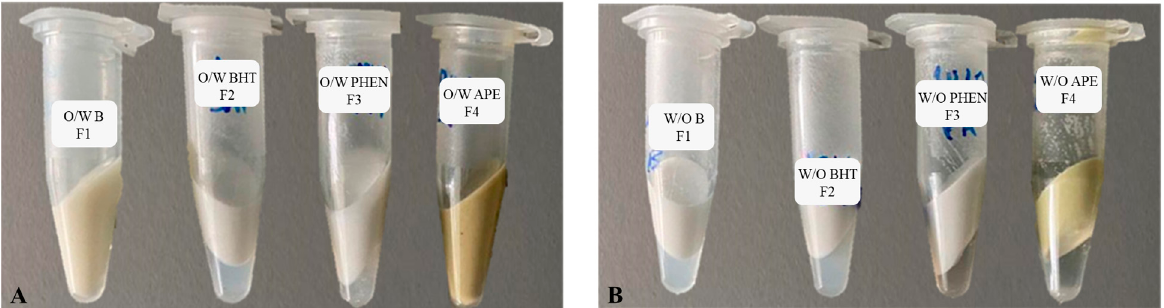
Figure 4. Results of the accelerated physical stability test after centrifugation at 5000 rpm for 10 min at room temperature: ( A ) O/W formulations F1 to F4; ( B ) W/O formulations F1 to F4. F1: base formulation without additives (negative control); F2: formulation with BHT (antioxidant positive control); F3: formulation with phenoxyethanol (PHEN) (antibacterial positive control); F4: formulation with the avocado peel extract (APE).